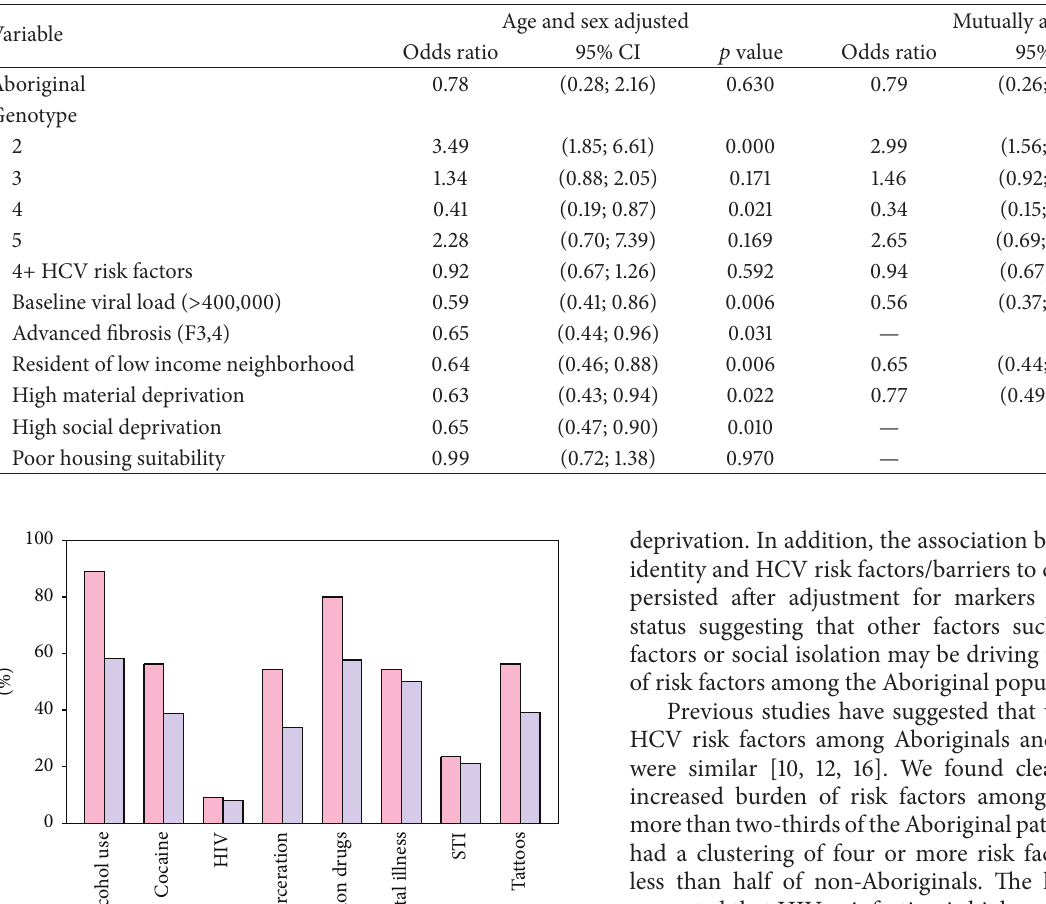
Table 4: Age and sex adjusted and mutually adjusted associations between achieving a sustained virologic response (SVR) and Aboriginal status, characteristics of HCV infection, and markers of socioeconomic status.